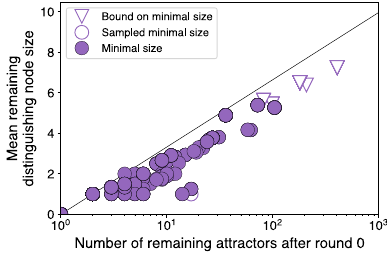
Fig. 6 Average 〈 ∣ w ∣ 〉 values for increasing length n of random n -tuples. Each point is averaged over random realizations of A . The shaded region around each curve marks the minimum and the maximum averages we fi nd. log 2 r looks like an effective upper bound for not just the average 〈 ∣ w ∣ 〉 , but also the individual values of 〈 ∣ w ∣ 〉 for all choices of n , r , and the number of simulations we consider. Remarkably, 〈 ∣ w ∣ 〉 never departs from log 2 r by more than a few units.